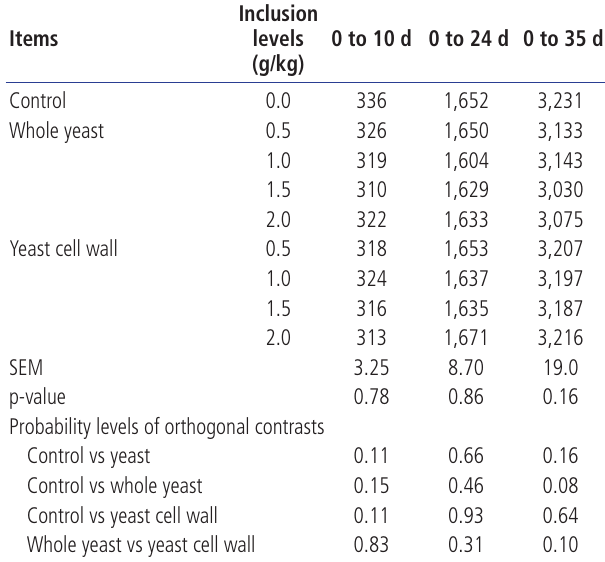
Table 2. Effects of dietary treatments on feed intake (g/bird) of chicks at different ages